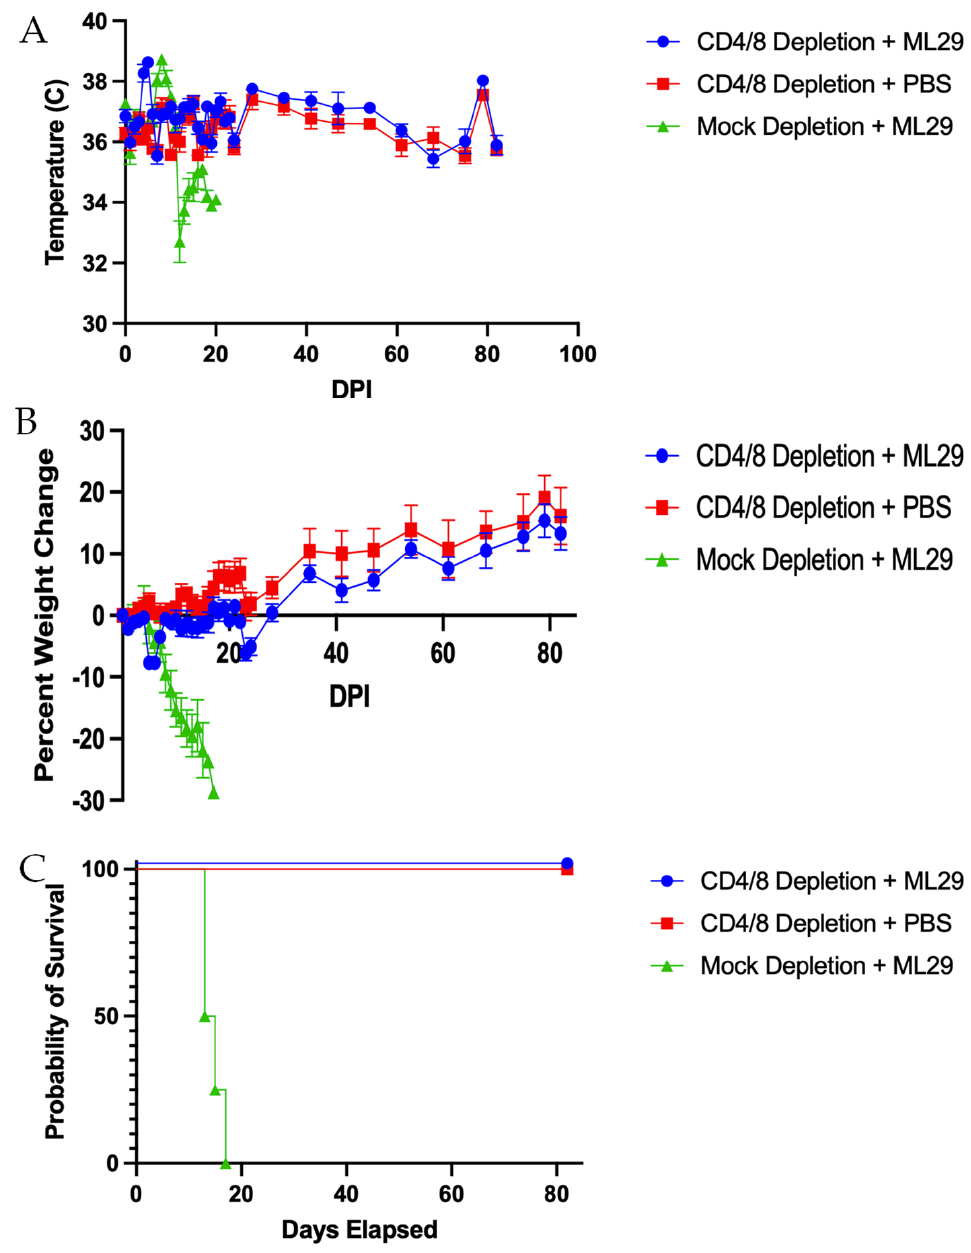
Figure 2. Acute disease in ML29 infection is T cell dependent. STAT1-/- mice were either mock depleted or depleted of both CD4 and CD8 T cells and inoculated with ML29 or PBS as a mock control. ( A ) Changes in body temperature post-infection. ( B ) Changes in body weight post-infection. ( C ) Percent survival. n = 5 Depletion + ML29; n = 4 Depletion + PBS; n = 4 Mock Depletion + ML29. Data presented as mean ± SEM for temperature and weight